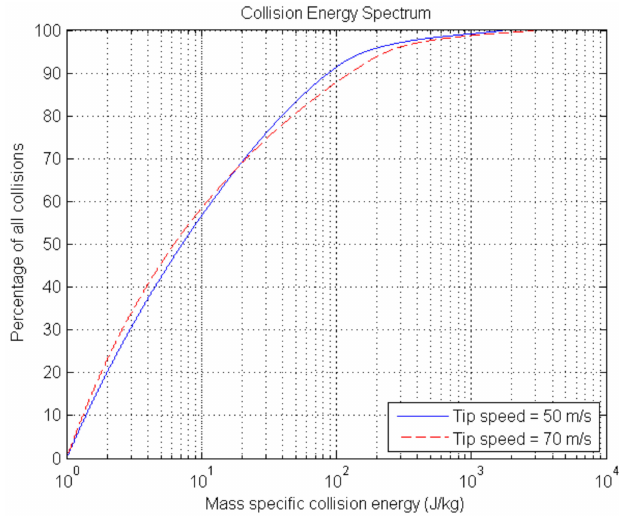
Figure 1. The distribution of particle collision energies inside a discrete element method (DEM) simulation of a vertical shaft impact (VSI). Two different rotor tip speeds were